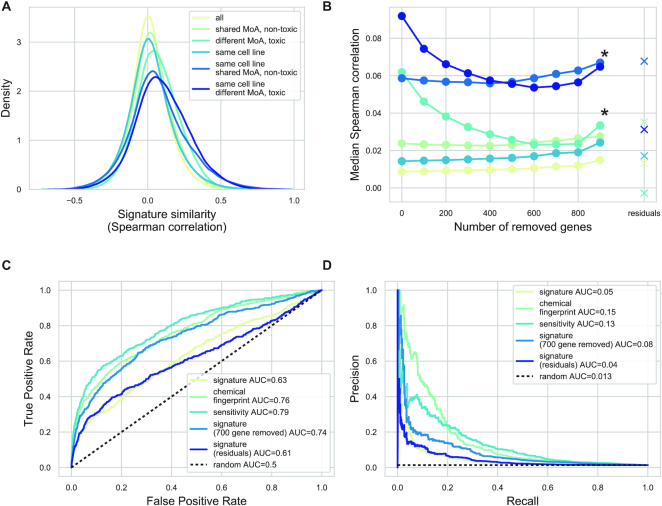
Cell viability signature as a confounding factor for mechanism of action discovery. (A) Mechanism of action and cell viability based signature similarity. Spearman correlation (x axis) was calculated for pairs of CTRP-L1000-24h signatures with the following constraints (color code): unrelated, nontoxic (cell viability >0.8) compounds with shared MoA and toxic (cell viability <0.8) compounds with different MoA. The Spearman correlation was calculated irrespective of cell line and for signatures from the same cell line. (B) The effect of removing cell viability correlated genes on signature similarity. Top n (x axis) genes with highest absolute Pearson correlation to cell viability were removed from the signatures before similarity calculation. The median Spearman correlations (y) axis are shown. The color code corresponds to (A) panel. Similarity for residual gene expression (after regressing out cell viability) was also calculated. *: significant effect (P < 0.001, for linear model coefficient) of removing cell death correlated genes (C and D). The effect of removing cell viability correlated genes on MoA discovery. Average signatures for 327 compounds from CTRP-L1000-24h dataset were calculated using the MODZ method, either using all genes or after removing 700 genes with the highest (absolute) correlation to cell viability. Signature similarity (Spearman correlation) was calculated for each compound pair. For comparison, chemical structure similarity (Tanimoto similarity of chemical fingerprints) and sensitivity profile similarity were also calculated. ROC (C) and Precision Recall curves (D) were used to evaluate the predictive performance of similarity scores on drugs with shared mechanisms of action.